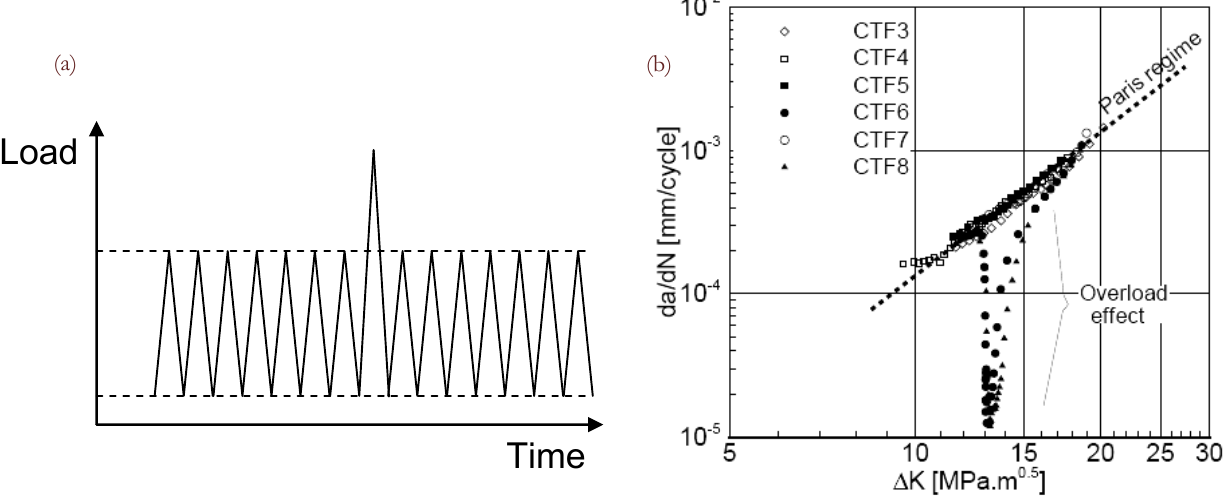
Figure 3: (a) Schematic load history for single overload specimen; (b) Variation of crack growth rate with nominal elastic  K for 3mm thick specimens, including two with single